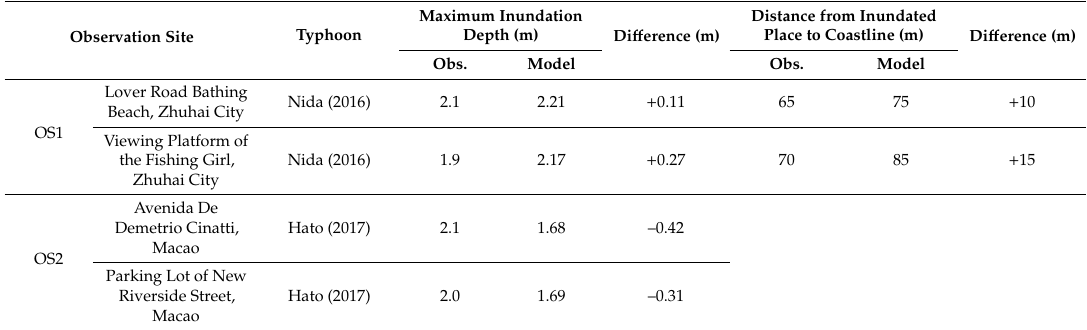
Table 3. Comparison of the inundation measurements and the corresponding model results at the observation